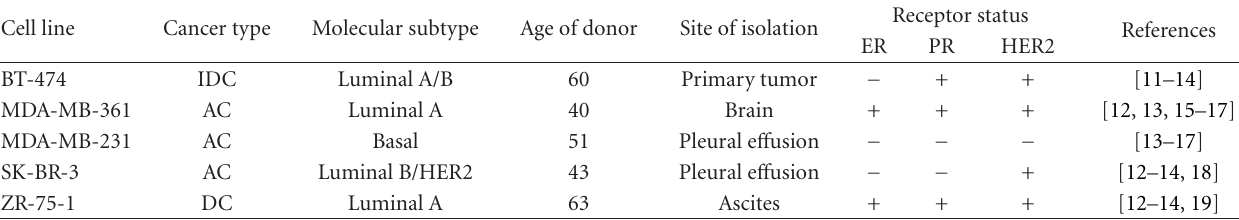
Table 1: Key features of the human breast cancer cell lines used in this study. Some lines can be classified into more than one subtype. Expression of ER and PR and amplification/overexpression of HER2 are indicated (+). Cell